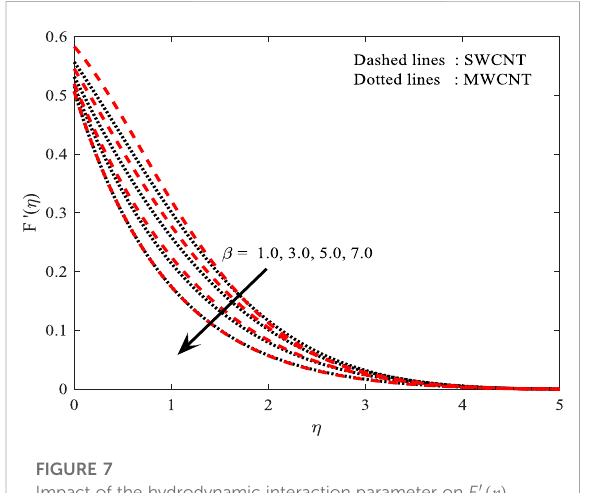
FIGURE 7 Impact of the hydrodynamic interaction parameter on F ′ ( η ) .